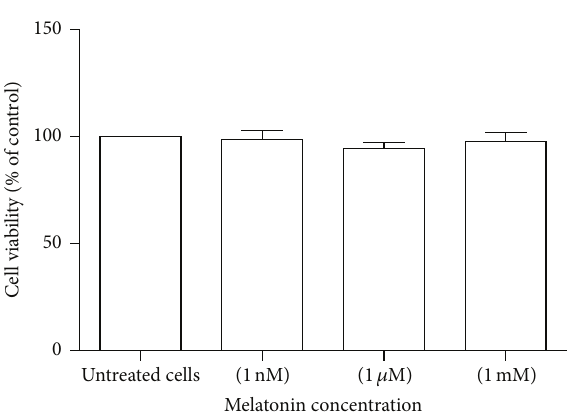
Figure 2: Assessment of PBMCs viability in response to H treatment. Cells were incubated with increasing concentrations of O (50 𝜇 M,100 𝜇 M,250 𝜇 M,and500 𝜇 M)for2handcellviability H 2 2 was determined by MTT assay. The MTT assay was performed in triplicate and data are reported from the mean of triplicates. Data are expressed as means ± SEM. ∗ 𝑝 < 0.05